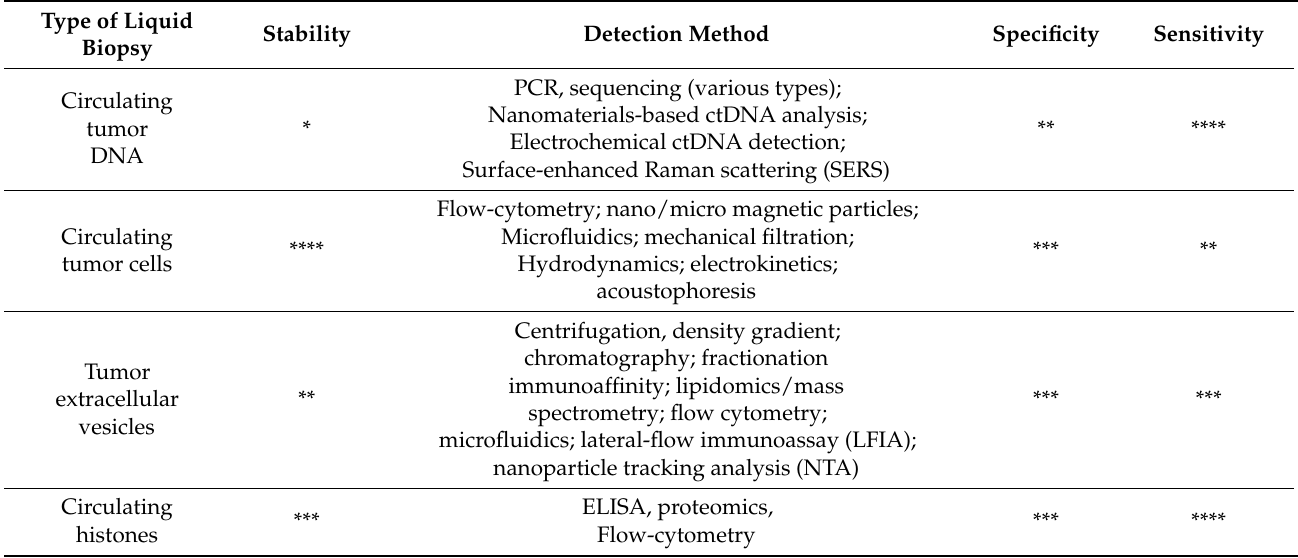
Table 1. Characteristics of the different types of liquid